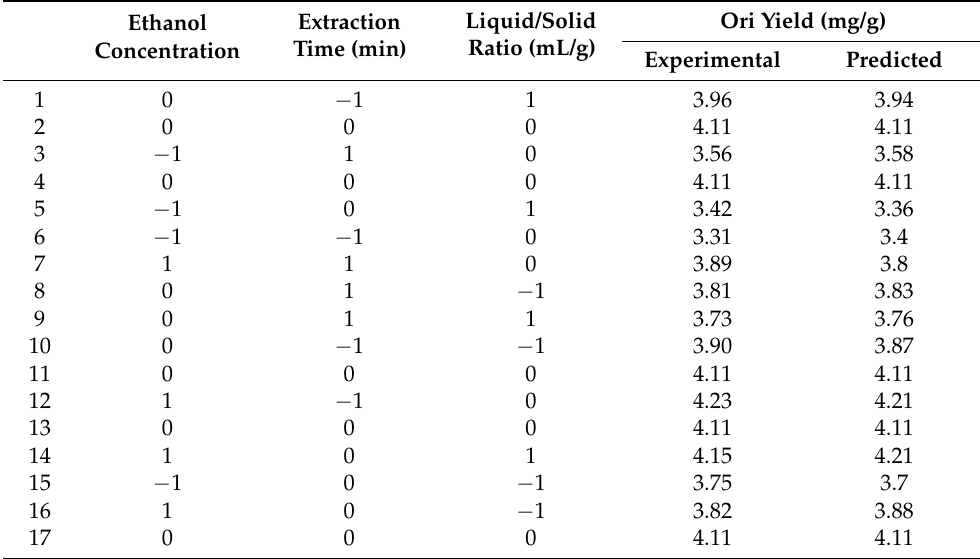
Table 3. BBD matrix and response values for the extraction yield of Ori.